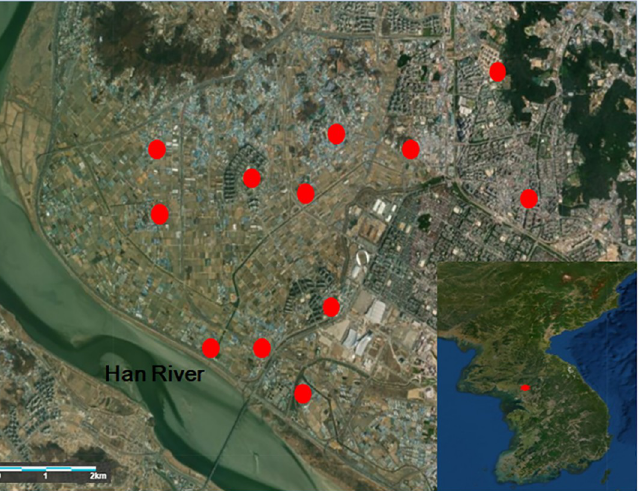
Fig 1. Locations of black light traps at 12 sites in Goyang, Korea, 2008–2012 (copyright map: Https://landlook.